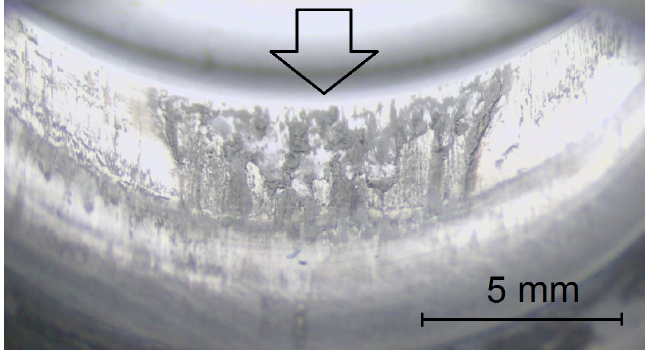
Figure 16. Typical wear of a forming die—irregular wear of the tool due to a poor lubrication with a